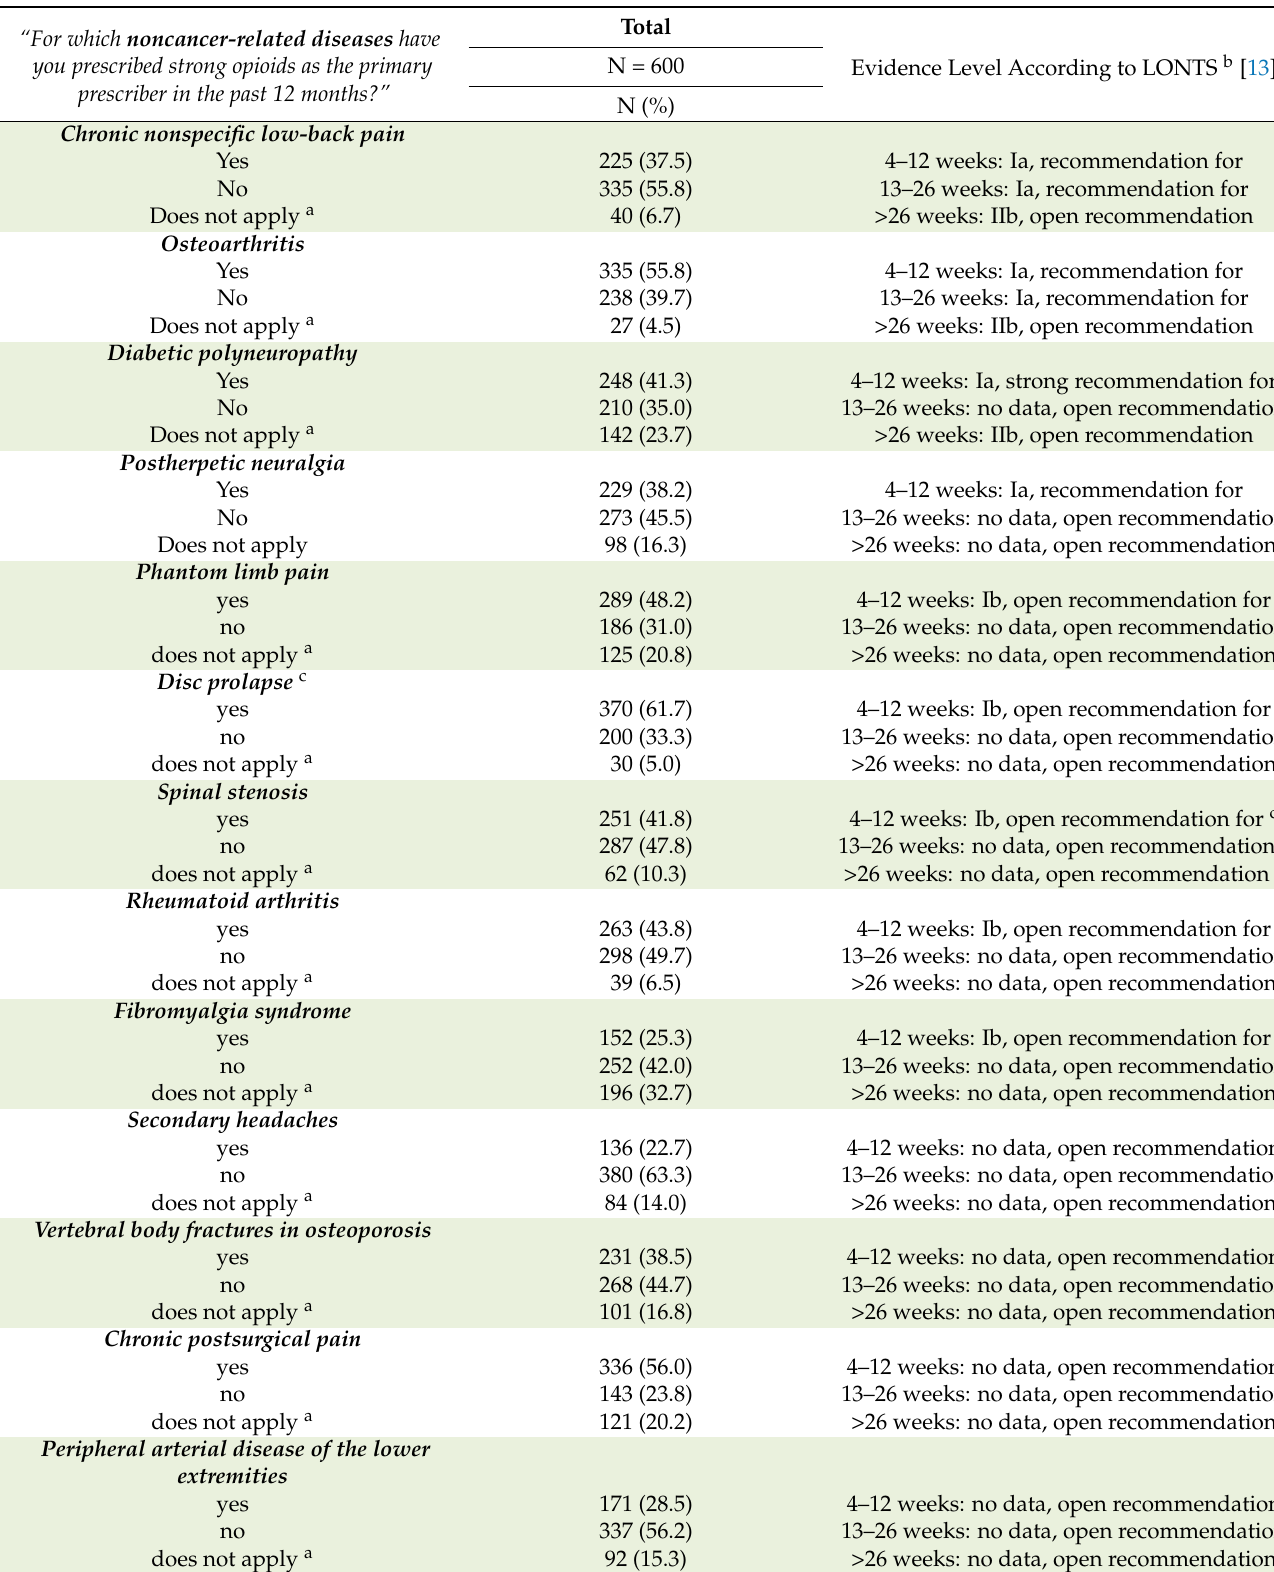
Table 3. Indications of physician self-reported opioid prescribing behavior compared to guide- line